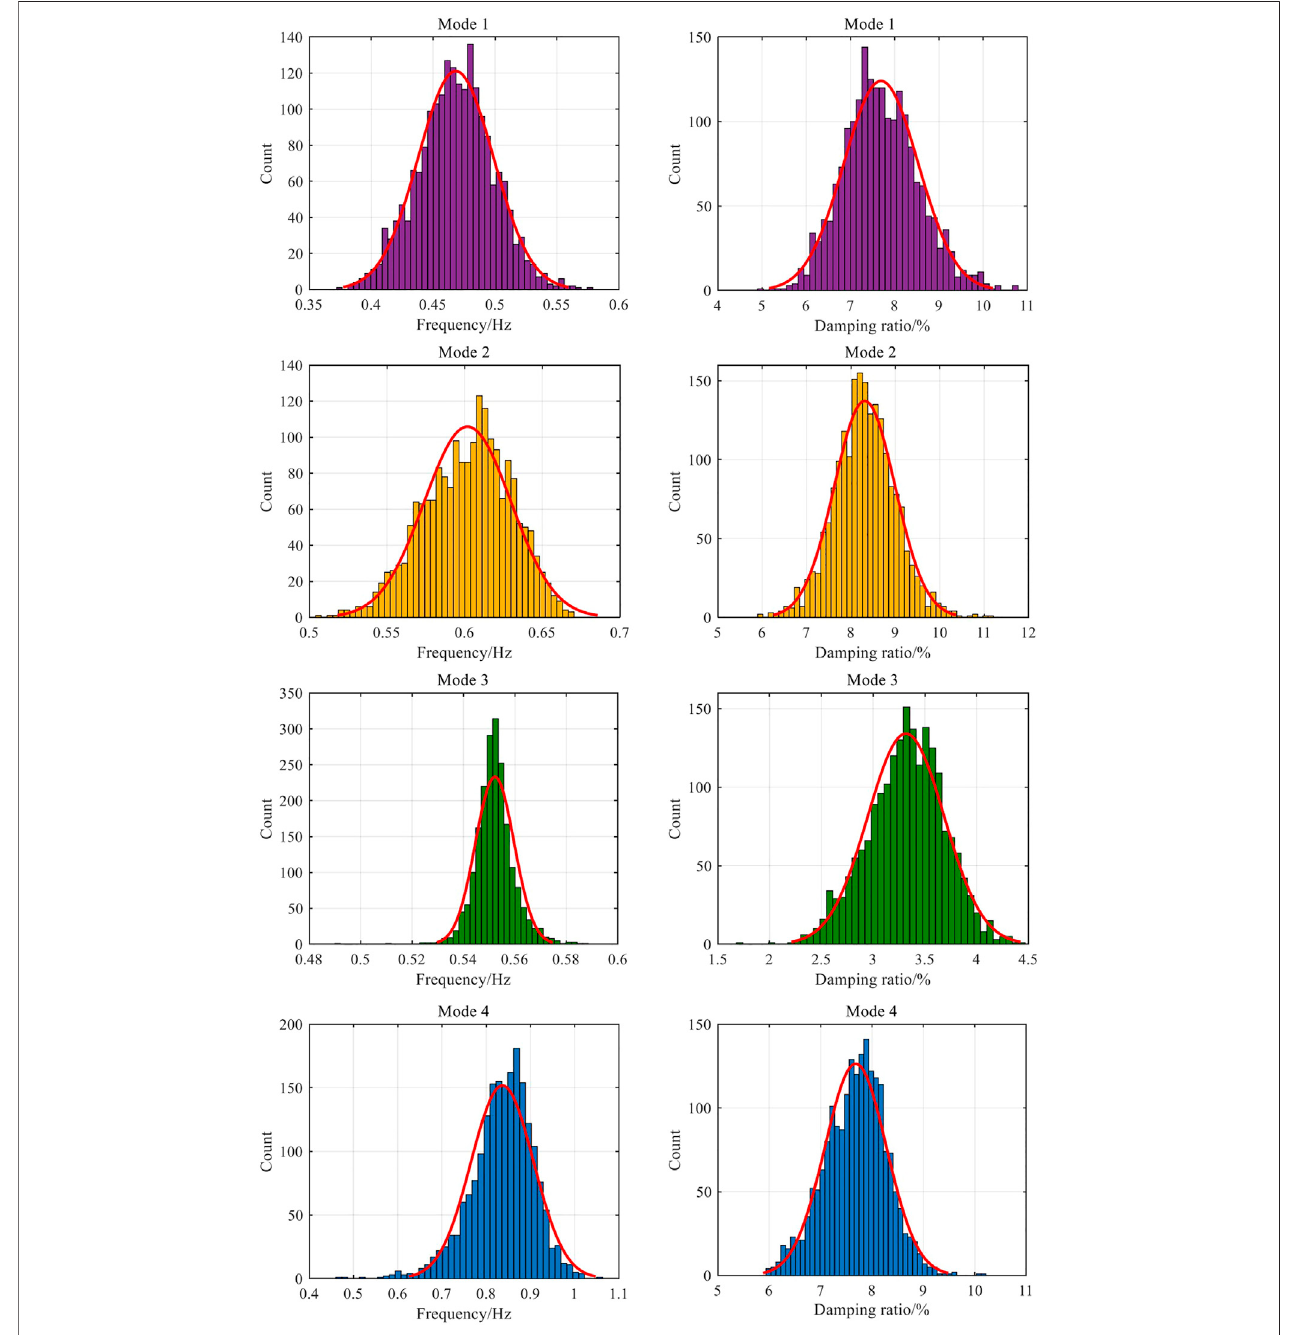
FIGURE 7 | Frequency histogram of frequency and damping ratio of four interval oscillation modes for the 16-generator 5-area system.